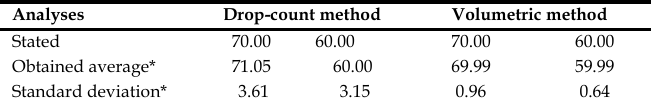
Table 2: Comparison of the two methods using 70% and 60% ethanol laboratory samples Analyses